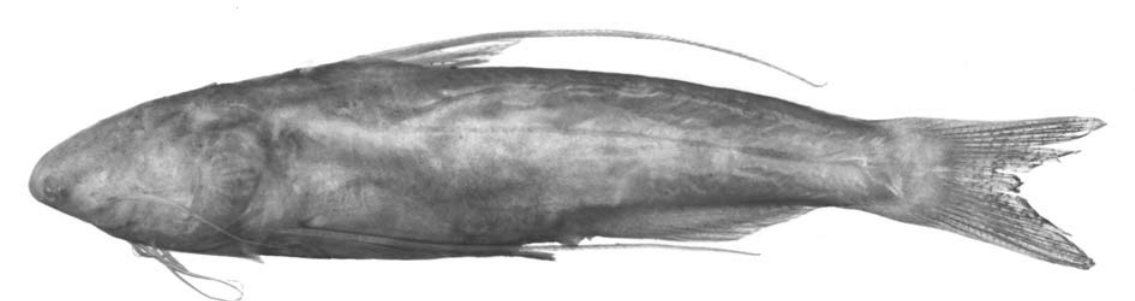
Fig. 29 . Cetopsis oliveirai, MUSM 9033, 30.6 mm SL; Peru, Madre de Dios, Palma Real (12°36’S